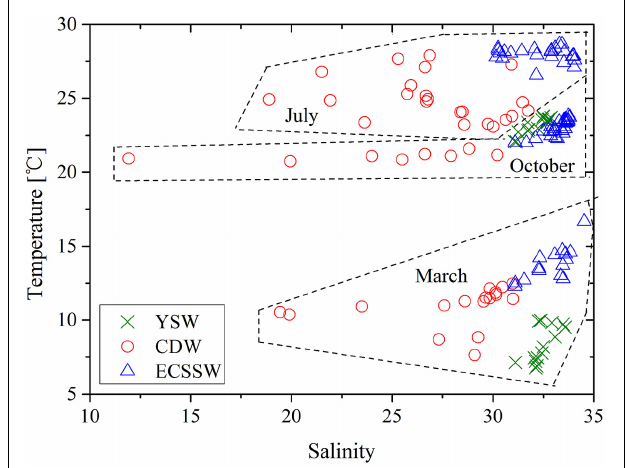
FIGURE 2 | Temperature versus salinity plot for surface water of the study area in March, July, and October, 2018, for three water masses: Yellow Sea Water (YSW), Changjiang Diluted Water (CDW), and East China Sea Shelf Water (ECSSW). Dashed boxes show separate water masses in different